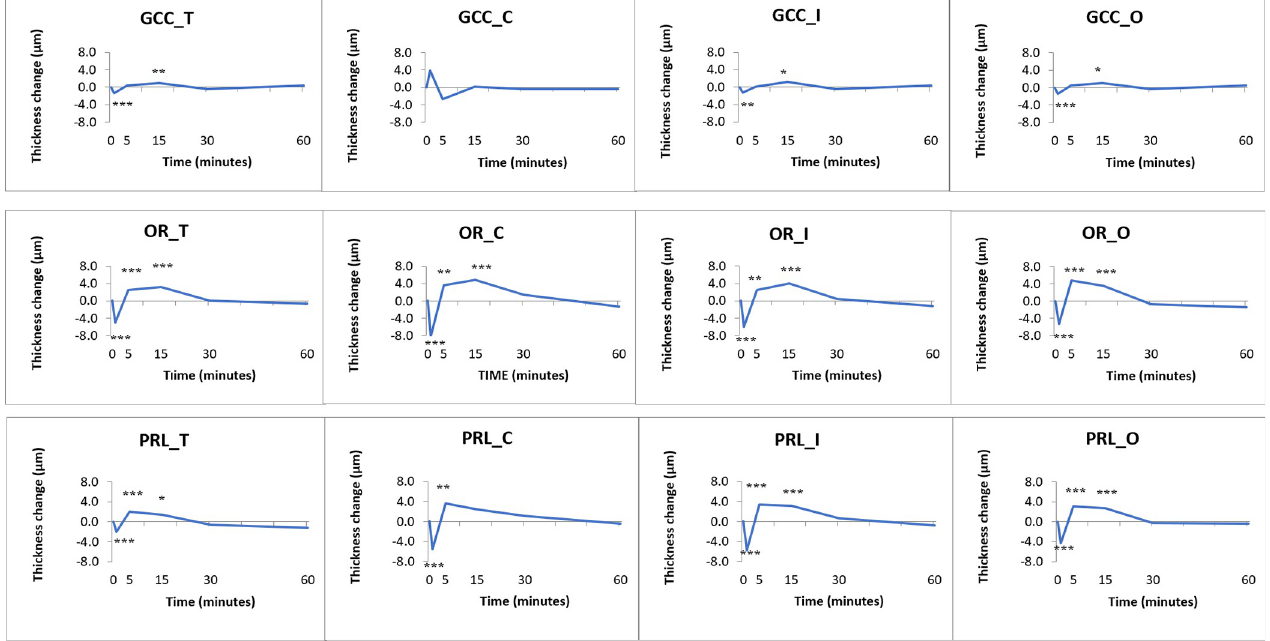
Fig 6. Changes observed in the composite layers of the macula. Data are shown in the total macular area (T), the central subfield (C), the inner (I) and outer ring (O). From top to bottom: GCC (RNFL+GCL+IPL), OR (OPL+ONL+IS+ELZ+OS+IDZ+RPE) and PRL (ONL+IS+ELZ+OS). � : p < 0.05 (missed significance), �� : p < 0.01 (missed significance), ��� : p < 0.001 (significant). For the mean and SD values see S5 Table. (For the abbreviations of the layers see Fig 2).